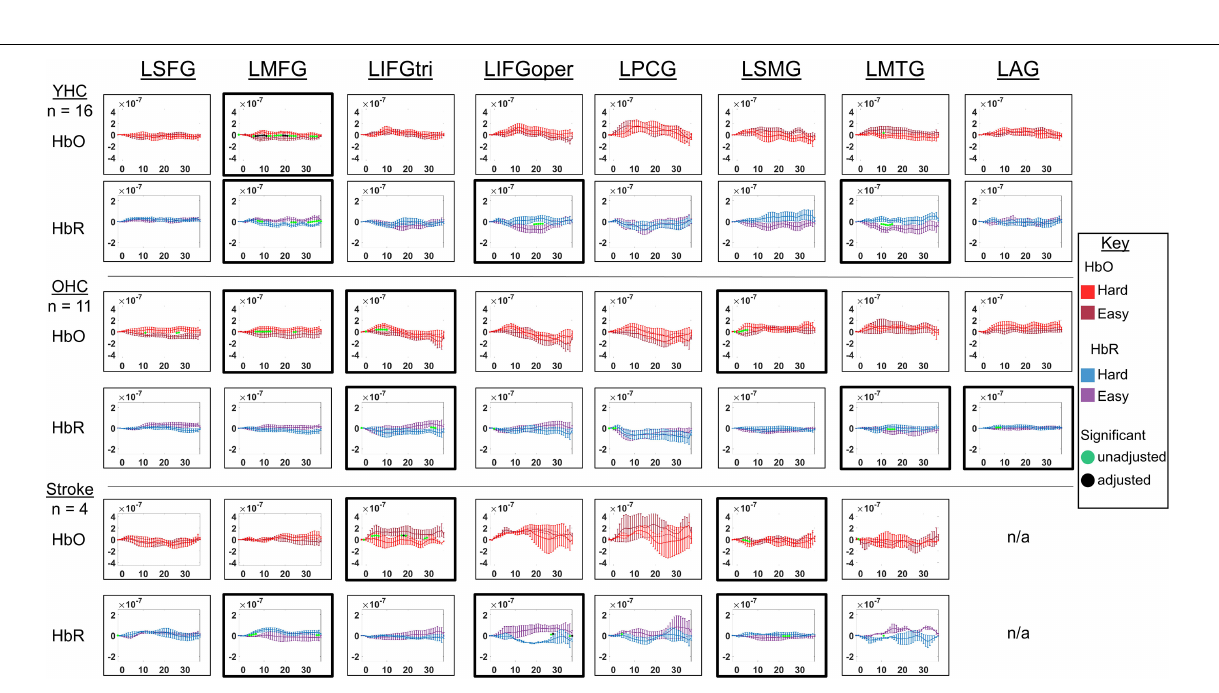
Frontiers in Human Neuroscience |